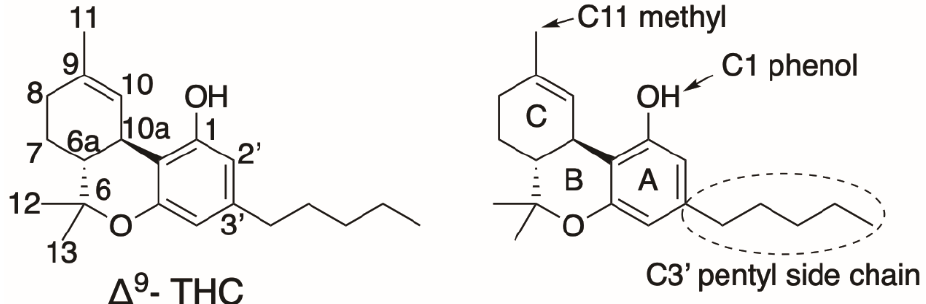
Figure 15. ( − )-trans- Δ⁹ - THC structural numbering and functional groups. Numerous THC docking and molecular dynamic simulation studies are available for CB1 (as well as CB2, to a lesser extent). Krishna et al. proposed that THC only has CB1 partial agonist activity because of its lack of interaction with the toggle switch